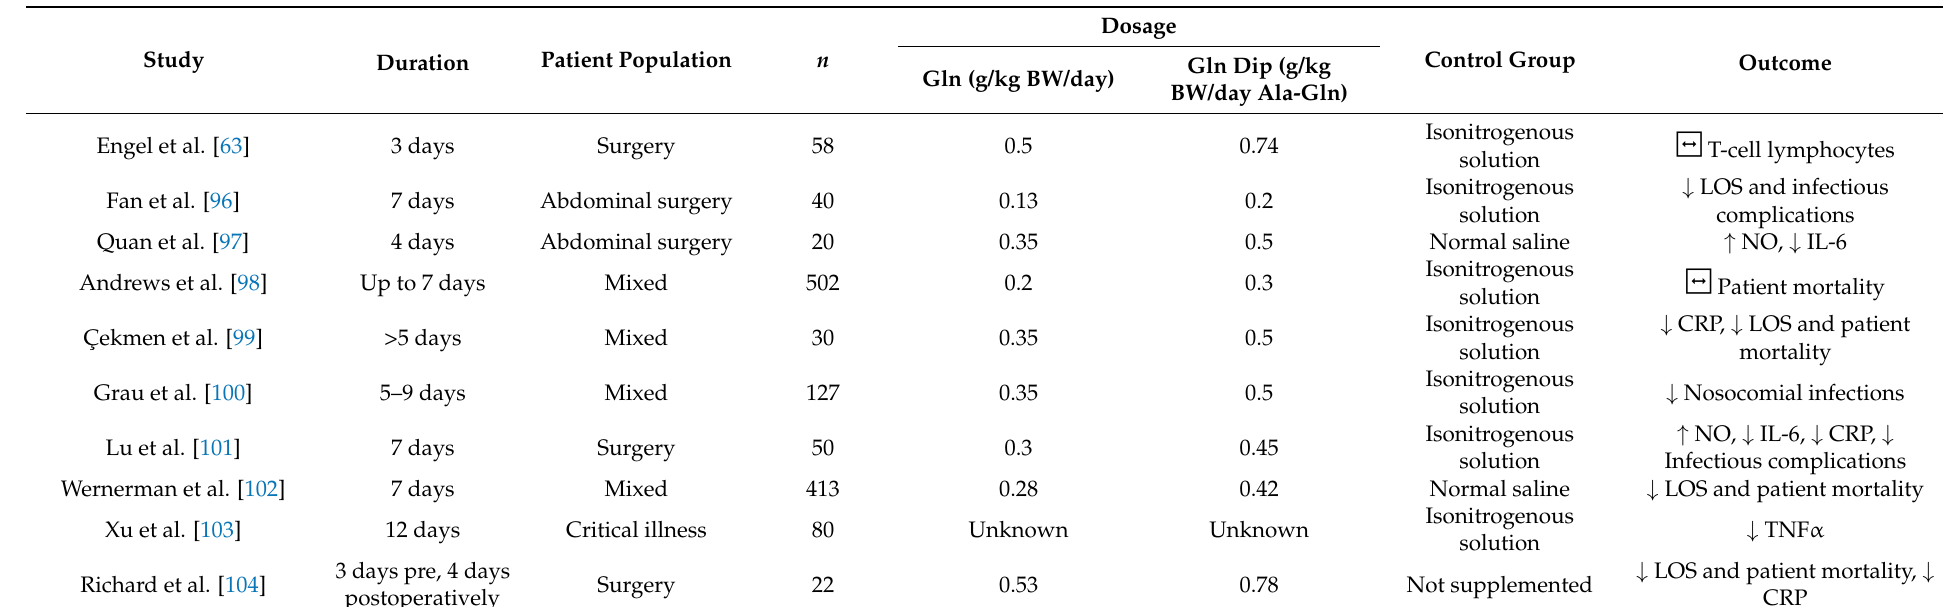
Table 2. Studies evaluating the effect of arginine supplementation on wound healing and reported